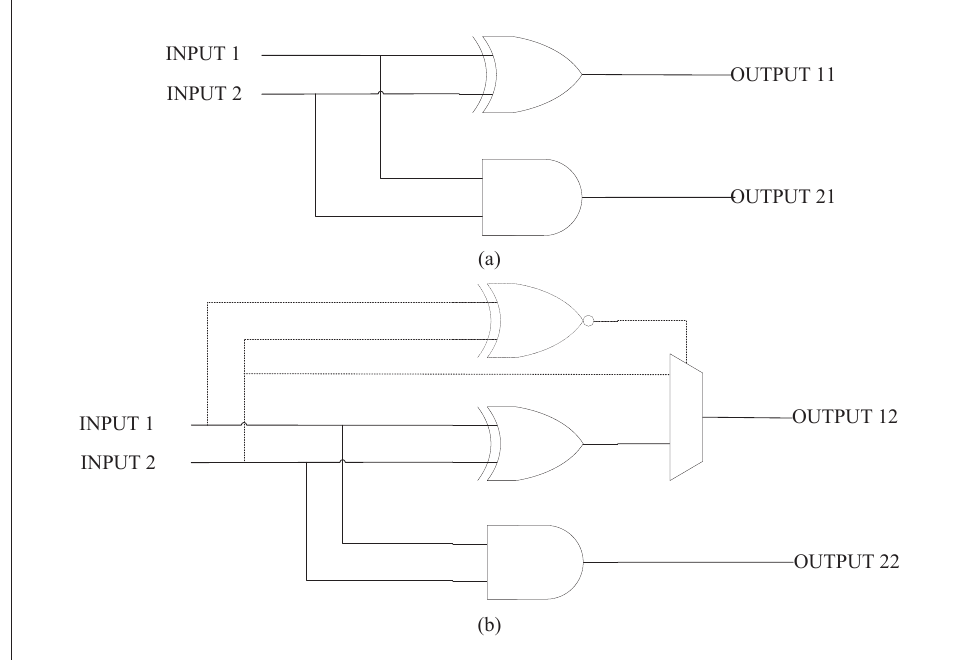
Figure 3. Hardware Trojan circuit ( a , b